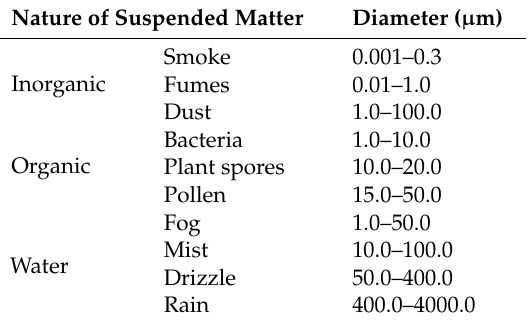
Table 2. The size range of typical pollution particles